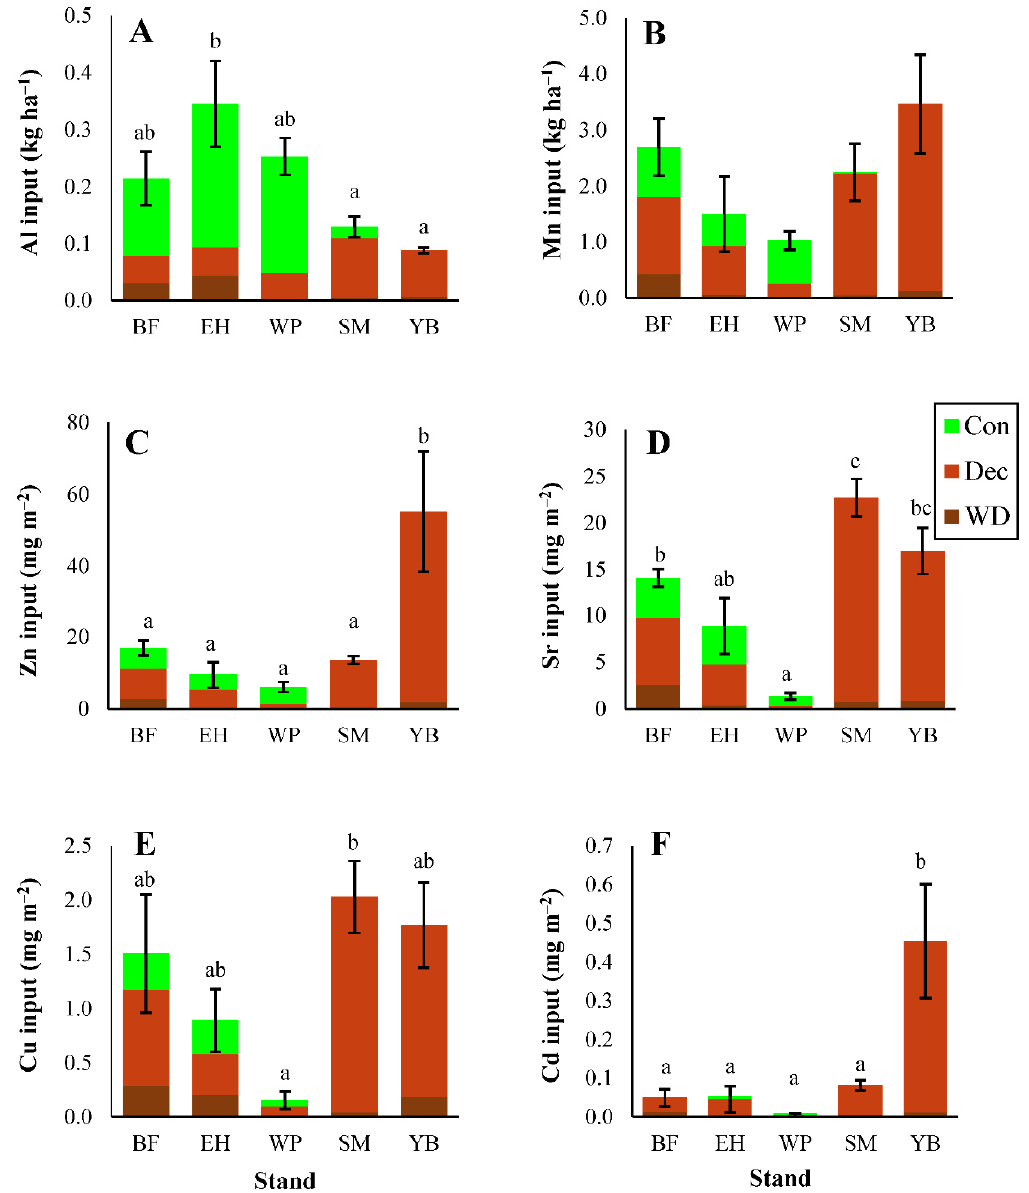
Figure 3. Inputs of aluminum (Al) ( A ), manganese (Mn) ( B ), zinc (Zn) ( C ), strontium (Sr) ( D ), copper (Cu) ( E ), and cadmium (Cd) ( F ) in each litterfall component (Con, Dec, WD). Different letters represent significant differences ( p < 0.05) in total litterfall inputs among stands; where letters are not present, significant differences do not exist. ANOVA test results shown in Table S10. Error bars indicate S. E. For BF, EH, and YB, n = 3. For SM and WP, n = 5.